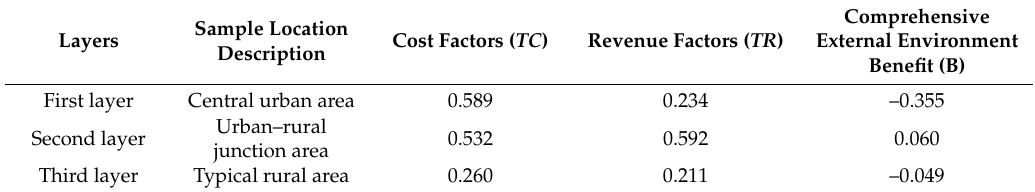
Table 3. Comprehensive benefit from external environment for ecological compensation of cultivated land protection in di ff erent layers in Chengdu.